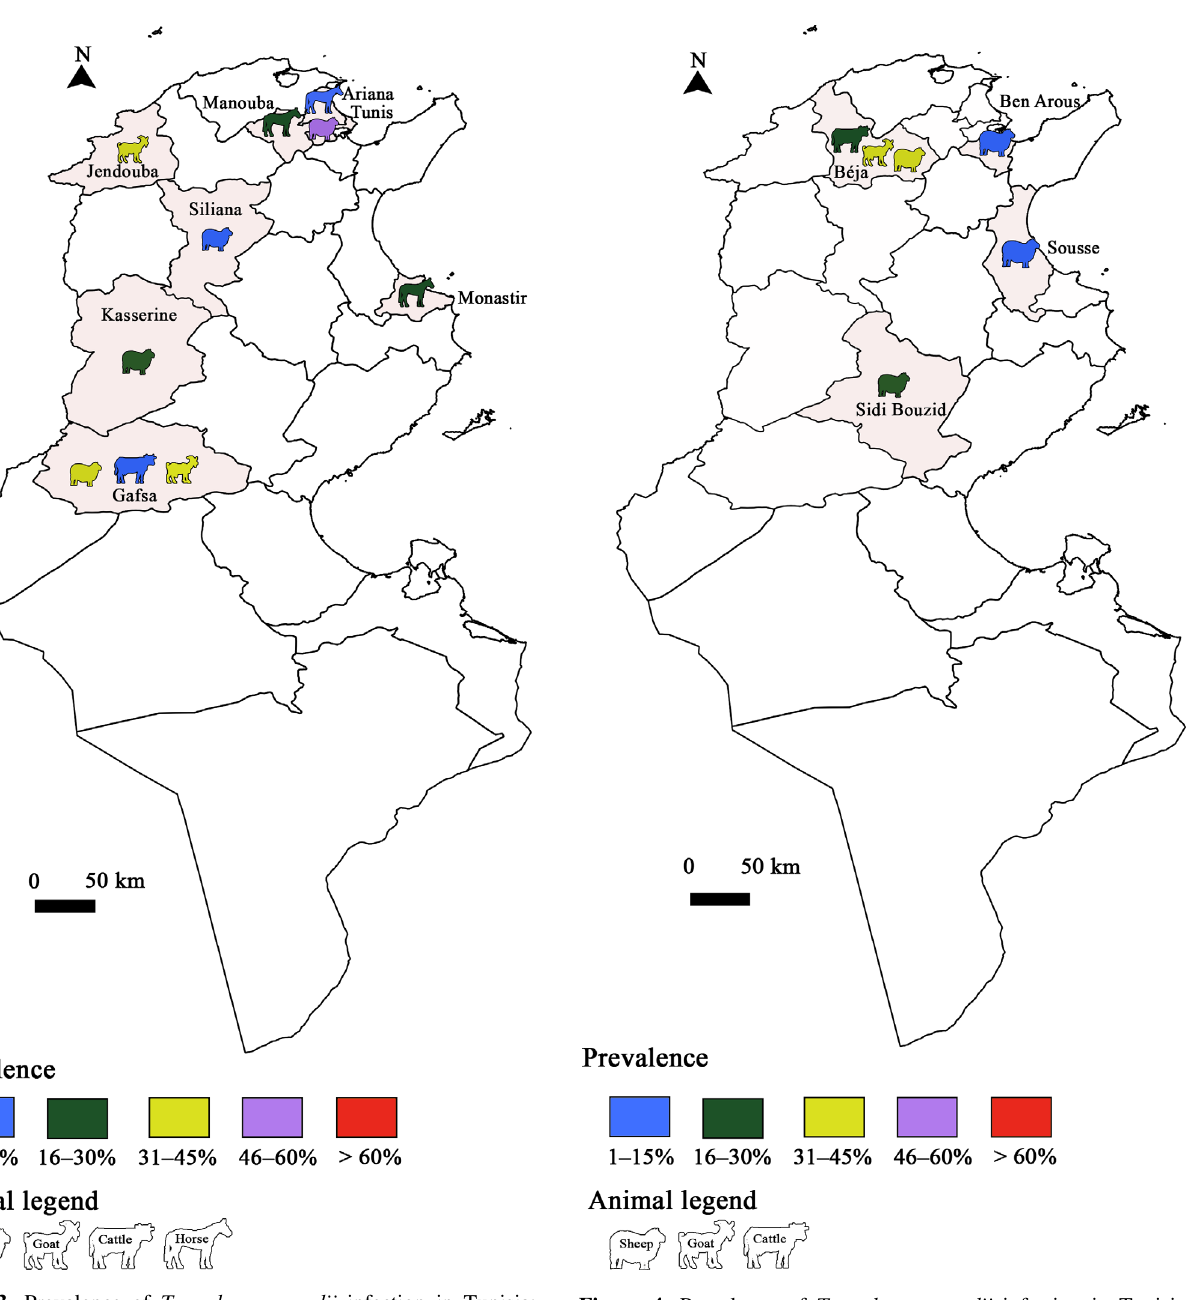
Figure 4. Prevalence of Toxoplasma gondii infection in Tunisia: Animal toxoplasmosis, molecular